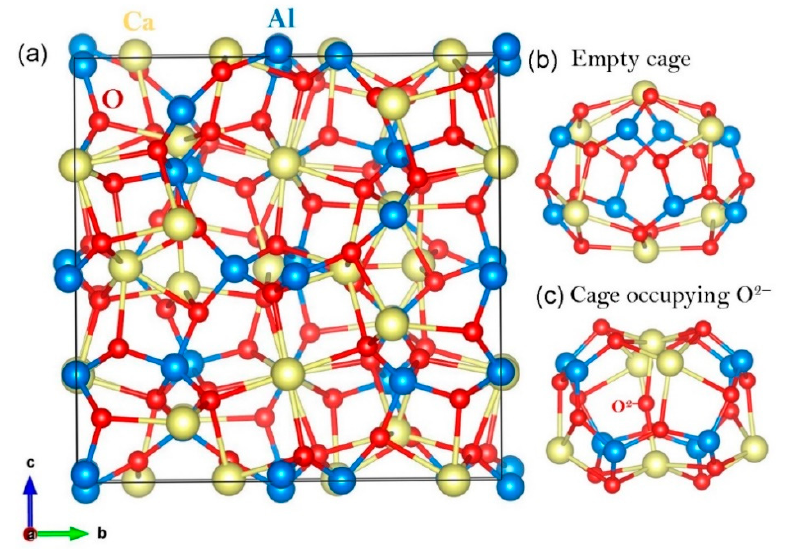
Figure 1. ( a ) Crystal structure of [Ca 24 Al 28 O 64 ] 4 + containing twelve empty cages; ( b ) and ( c ) optimised structures of an empty cage and a cage with an extra-framework O 2 − ion in C12A7:O 2 − , respectively.